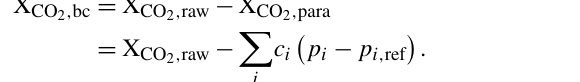
Figure 6. Standard deviation of d P ABP (a) and X CO of the weak (b) and strong (c) CO 2 bands as a function of z axis pointing offsets 2 , met for FP4 for the Death Valley National Park. To determine the minimum, only values that are distributed symmetrically around the minimum are taken into account for the quadratic